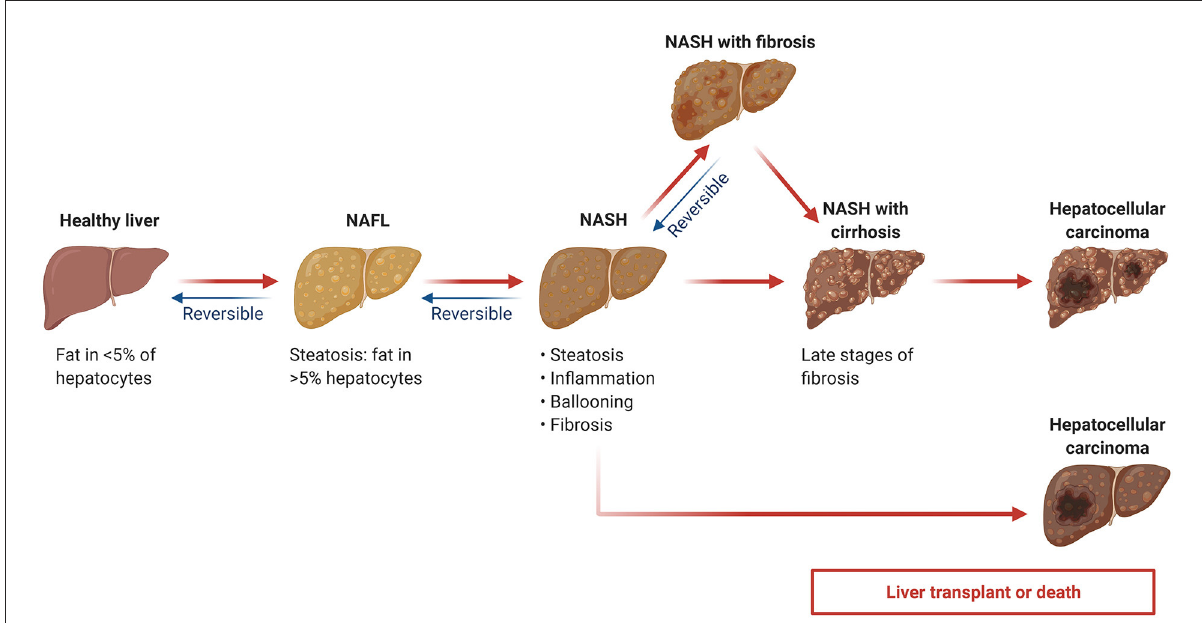
FIGURE1 Non-alcoholic fatty liver disease (NAFLD) progression. NAFL: non-alcoholic fatty liver; NASH: non-alcoholic steatohepatitis. Adapted from “Non-Alcoholic Fatty Liver Disease (NAFLD) Spectrum”, by BioRender.com (2022). Retrieved from https://app.biorender.com/biorender-